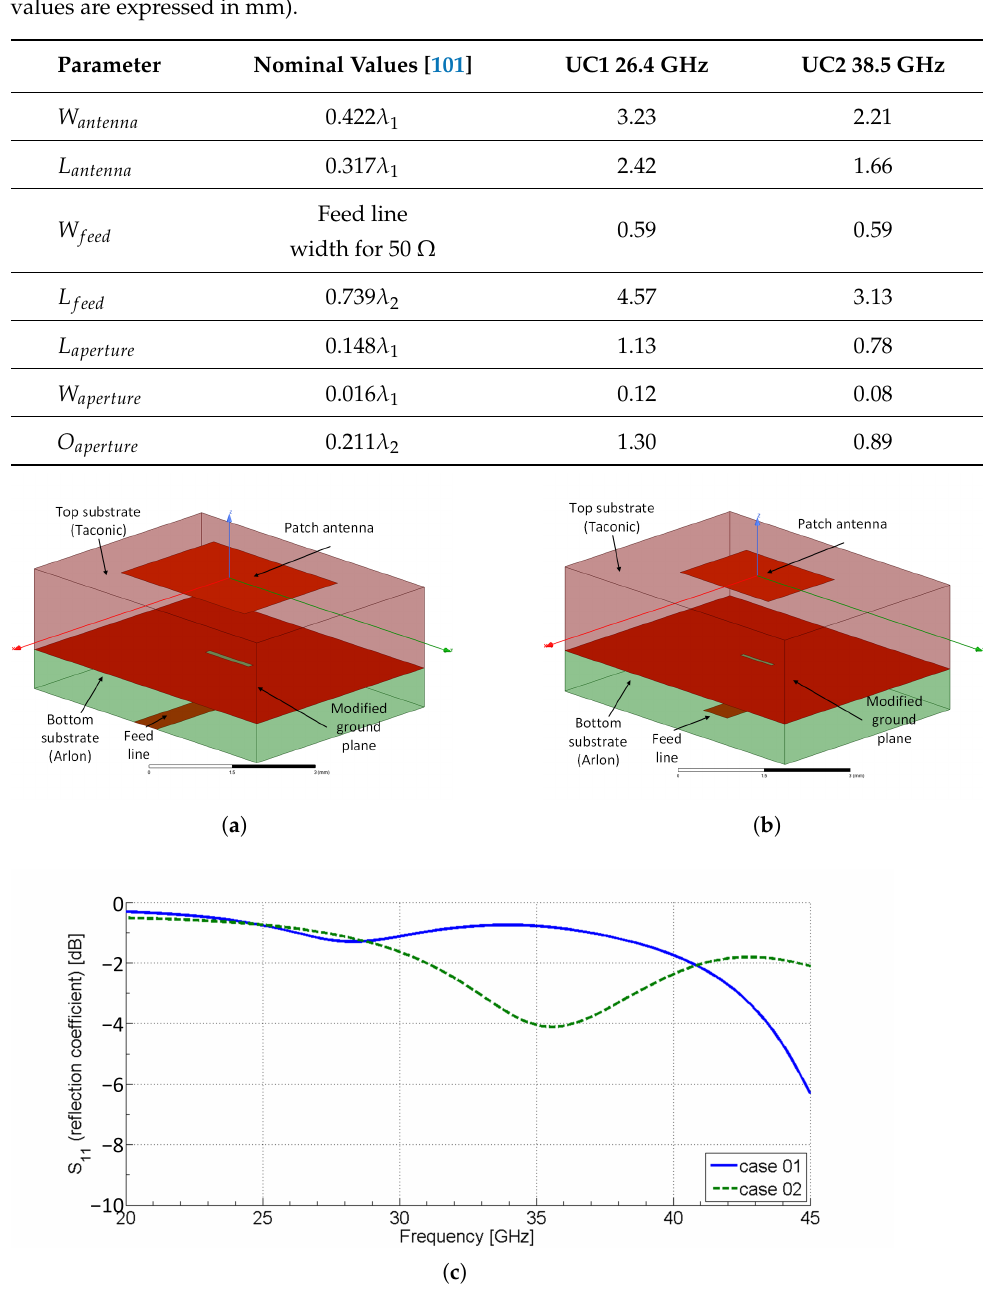
Figure 7. Perspective views and computed results of the reflection coefficient as a function of frequency for the two different use cases of an aperture-coupled patch antenna in the millimeter- wave frequency bands based on the design method described in [101] ( a ) use case 1 designed in the n258 frequency band (center frequency: 26.4 GHz), ( b ) use case 2 designed in the n260 frequency band (center frequency: 38.5 GHz), and ( c ) reflection coefficient (magnitude of S 11 ) as a function of frequency for the two different use cases of an aperture-coupled patch antenna in the millimeter-wave frequency